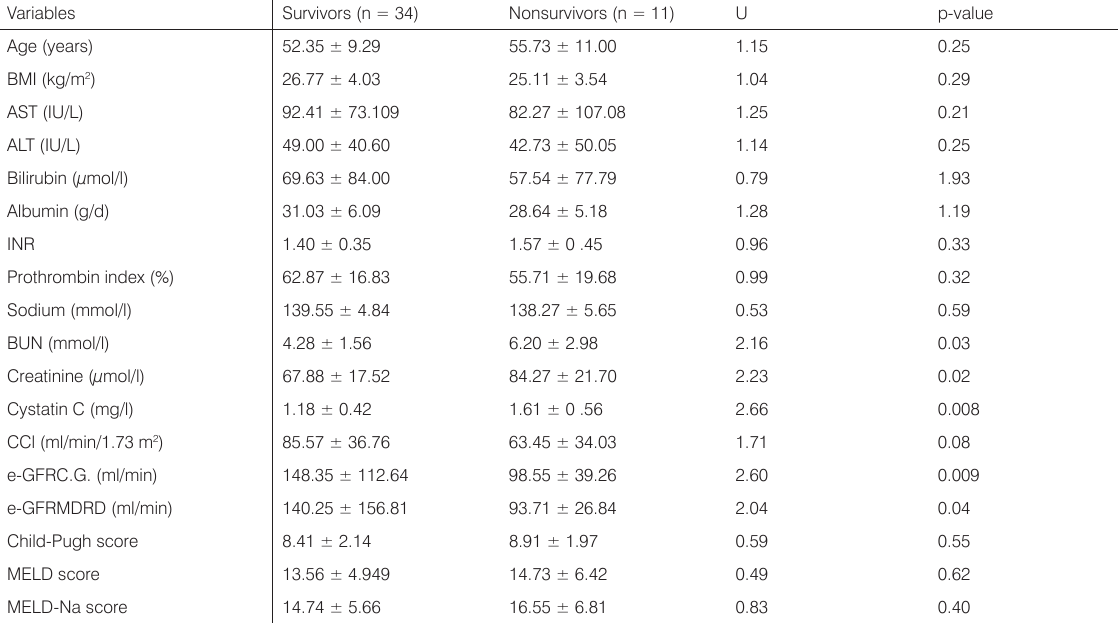
Table 2. GFR markers and liver function scores according to overall mortality (mean±SD; Mann-Whitney U test).